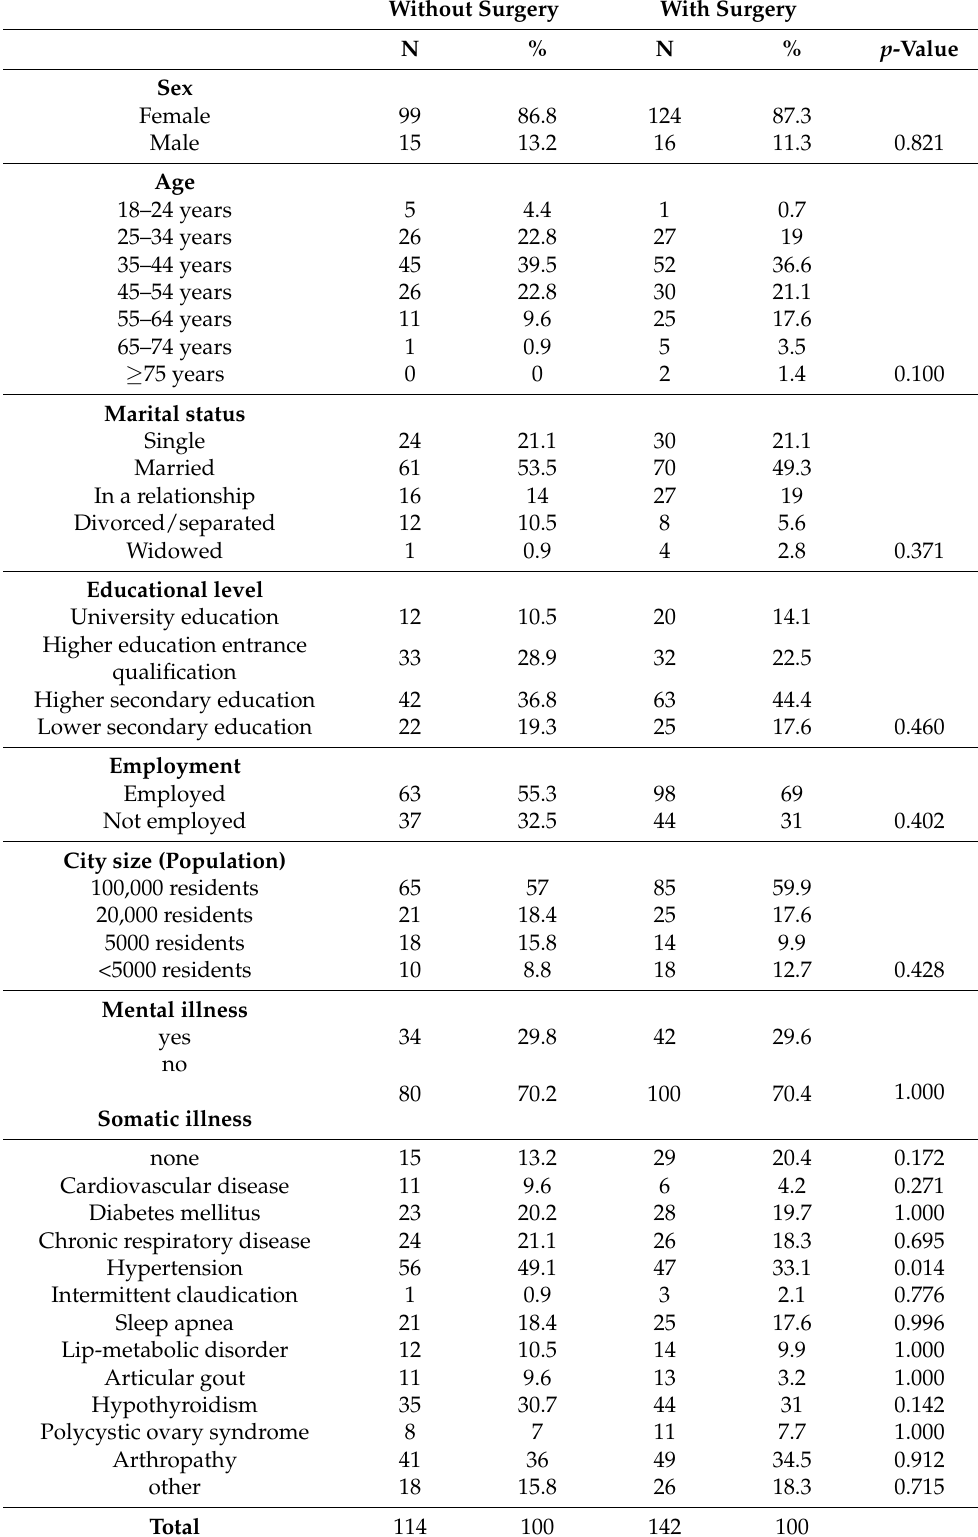
Table 1. Sociodemographic characteristics separately for both groups (with and without